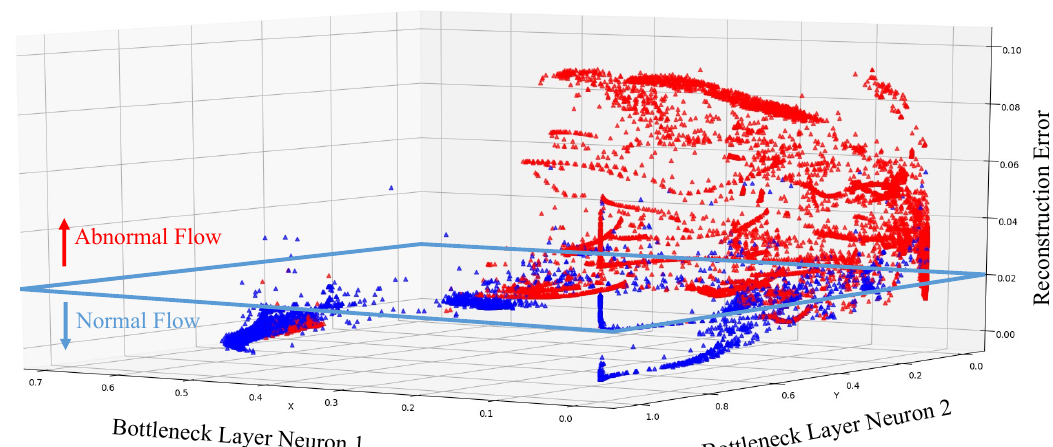
Figure 9. The visualization of the DAE_1 model’s reconstruction error.